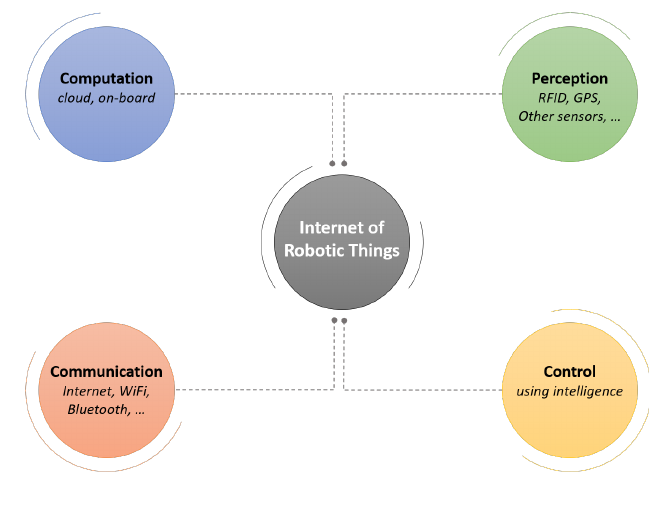
Figure 3. Overview of IoRT